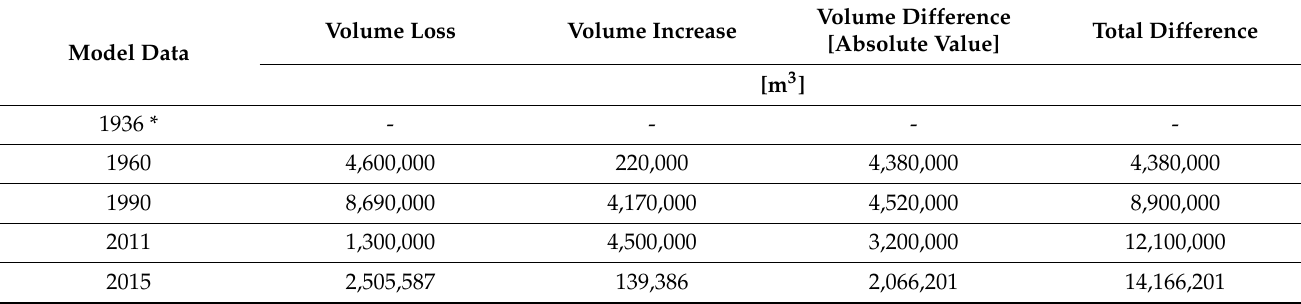
Table 2. Results of the calculated volume differences of the end moraine of the Werenskiold Glacier in each of the analyzed